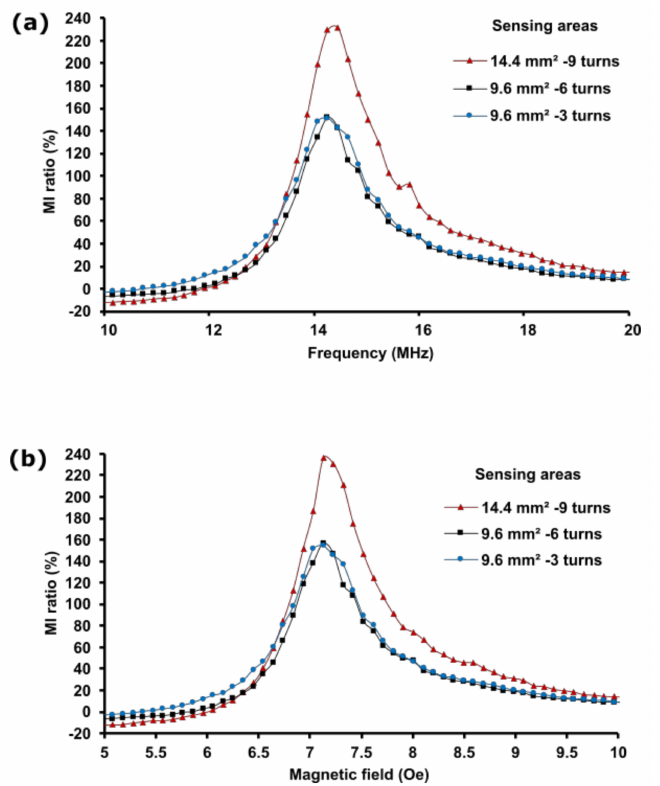
Figure 7. MI ratio based on sensing area variation. ( a ) Frequency dependence of the MI ratio. ( b ) Field dependence of the MI